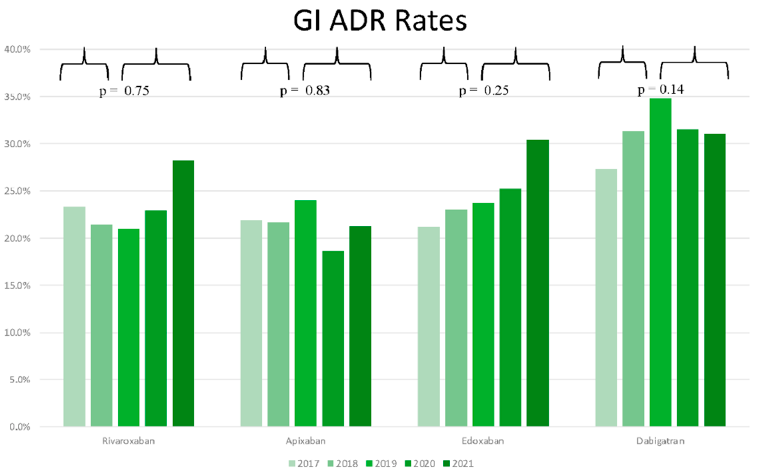
Figure 4. Rates of GI ADR relative to total ADR for each molecule for all study years.